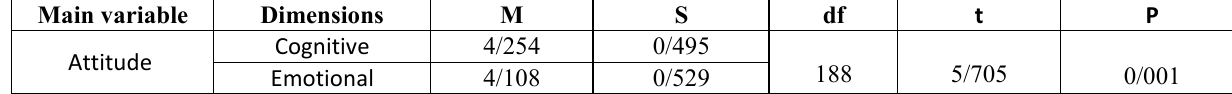
Table3: results of t-test about attitude according to cognitive and emotional dimensions